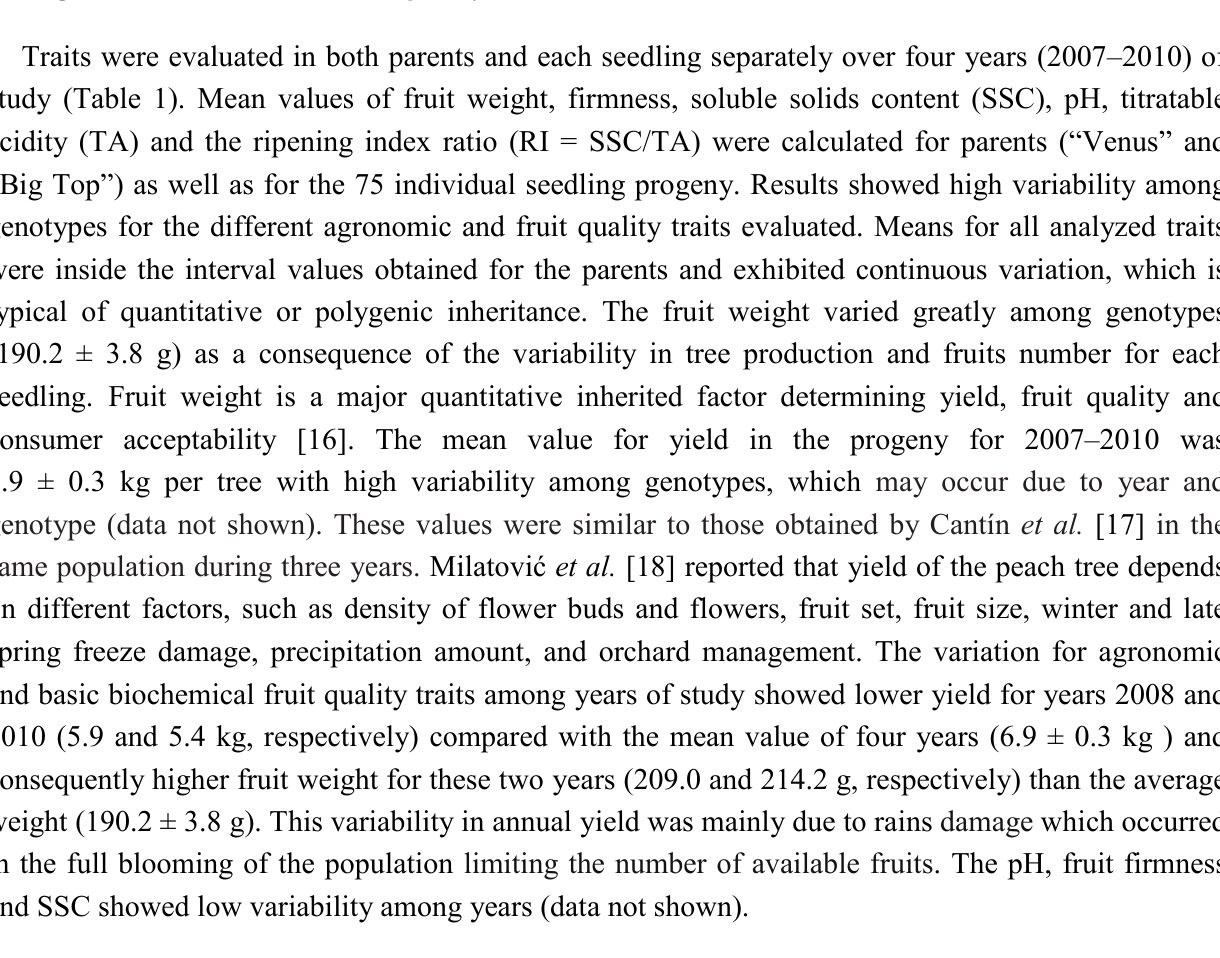
Table 1. Agronomical and basic fruit quality traits in the “Venus” × “Big Top” population. For progenitors data are means ± SE of two years (2009–2010). For the progeny ( n = 75 genotypes), data are means ± SE of four years of study